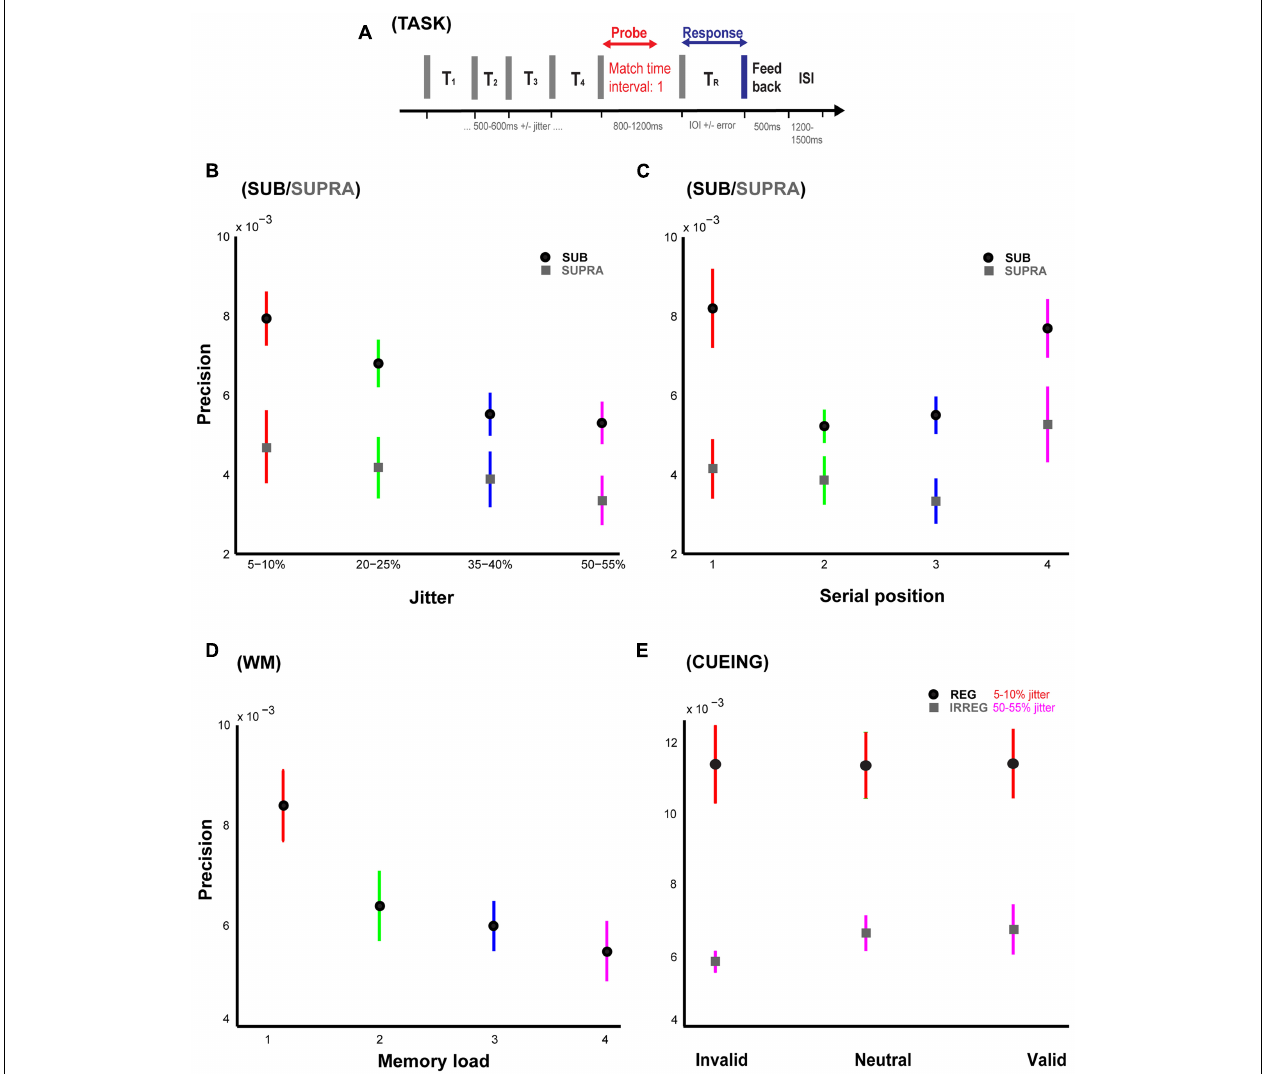
Data with the mean indicated by black and gray circles is from Experiments 1 and 2 respectively. (C) Precision vs. serial position in Experiments 1 and 2. Precision is plotted as a function of the serial position of the probed interval which could occur randomly at either the first (red), second (green), third (blue), or the fourth (pink) positions. Data with the mean indicated by black and gray circles is from Experiments 1 and 2 respectively. (D) Precision vs. working memory load in Experiment 3. Precision is plotted as a function of the number of intervals which was the variable of interest in Experiment 3. The intervals were presented at any of the four jitter levels as in Experiments 1 and 2. (E) Precision vs. cue in Experiments 4A and 4B. Precision for invalid, neutral, and valid cues is plotted in blue for a sequence of regular intervals (jitter of 5–10%) and in red for a sequence of irregular intervals (jitter of 50–55%). Error bars represent one SEM.